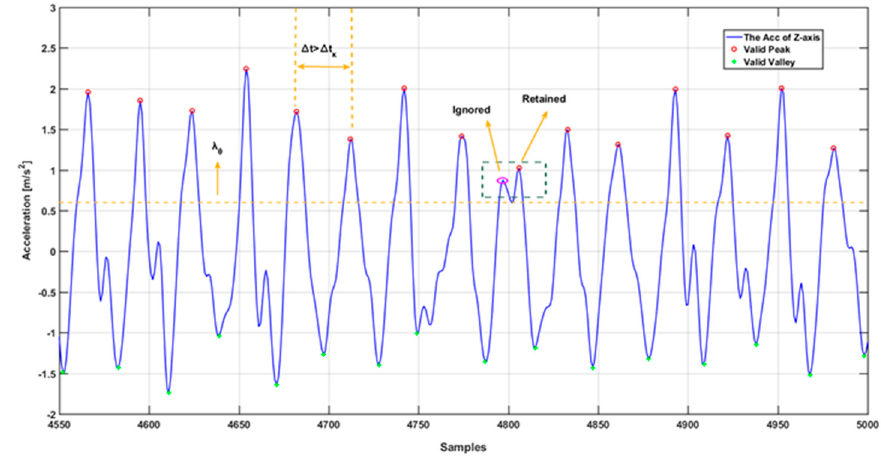
Figure 7. Detection of the valid steps.